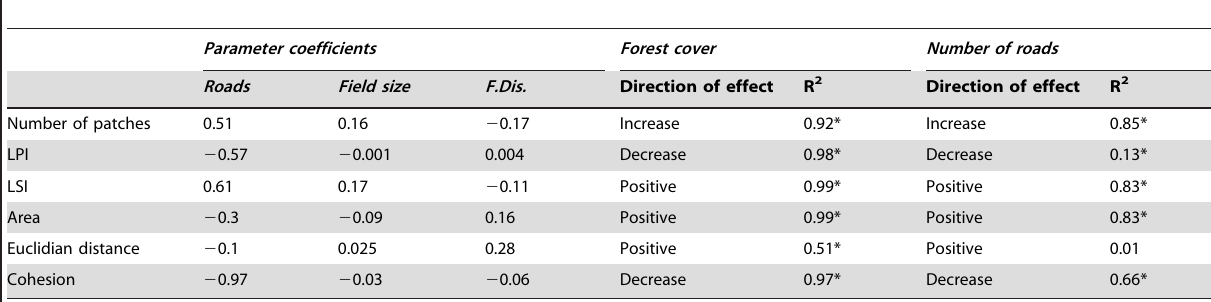
Table 3. Results of Multiple Regression to assess sources of model variability in G-RaFFe